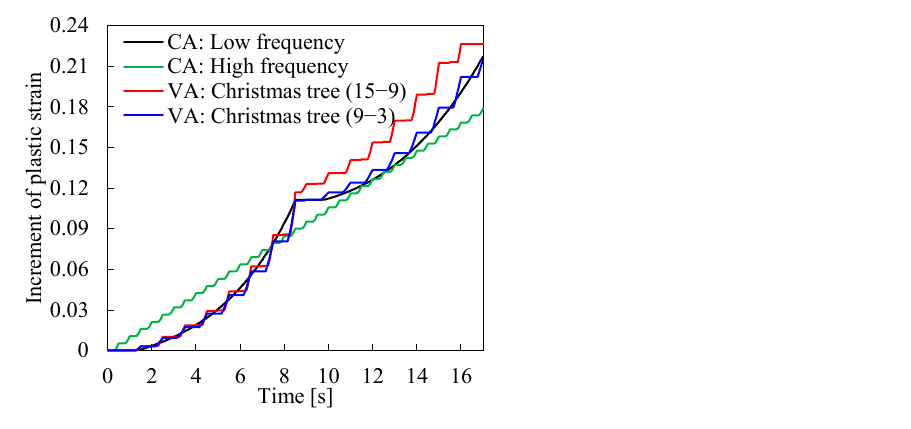
Figure 9. Comparison of plastic strain curves for point a = 15.30 mm in non-contact simulations.